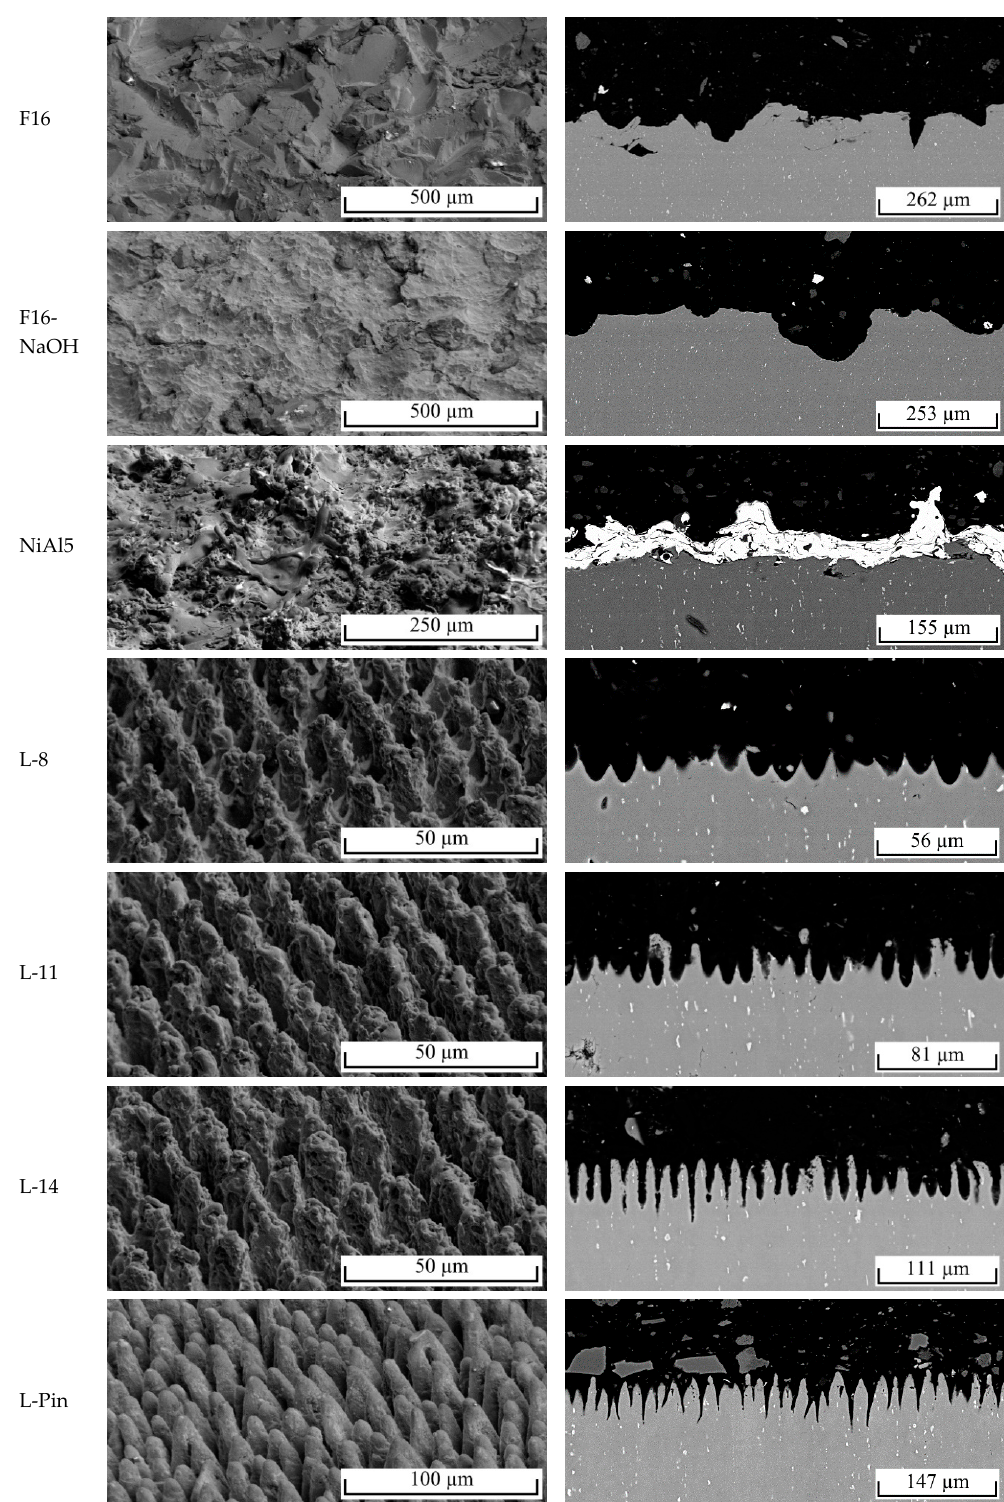
Figure 7. Scanning electron microscopy (SE) images of topography (left) and cross-sectional back scattering detector (BSD) images (right).